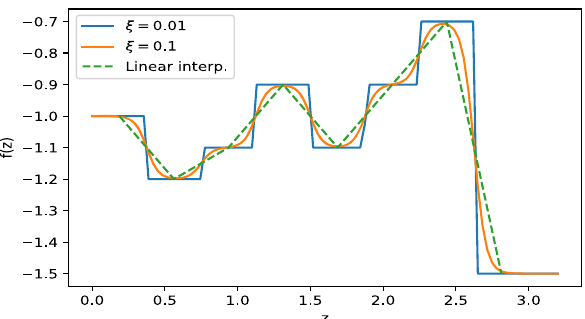
Fig. 1 Example of the reconstruction plot for the f ( z ) function with 8 nodes and bins. We observe the difference in the reconstruction when using two values for the smoothness parameter